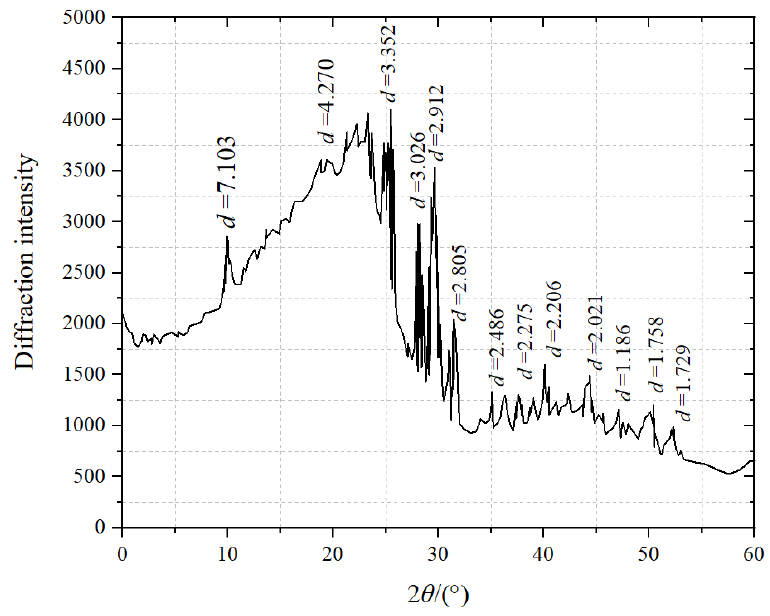
Figure 3. X ‐ ray diffraction pattern of outburst proneness coal. Figure 3. X-ray diffraction pattern of outburst proneness coal. Table 1. Grouping of coal samples.